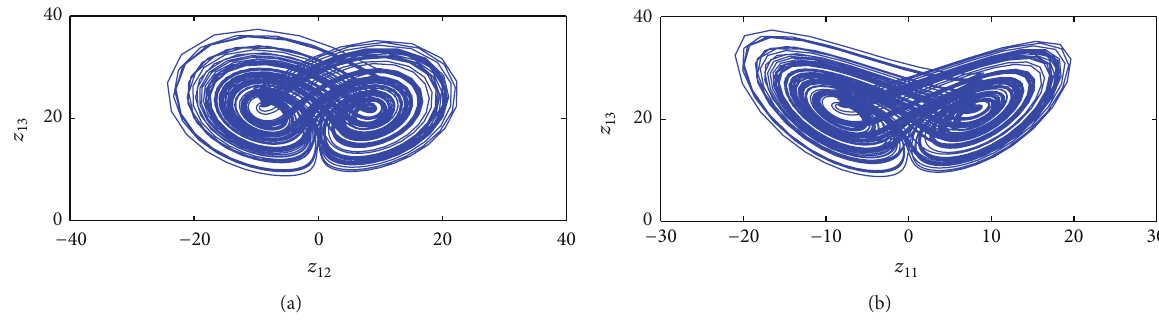
Figure 2: The chaotic attractor of system (20) for 𝑞 𝑑1 = 0.9 .